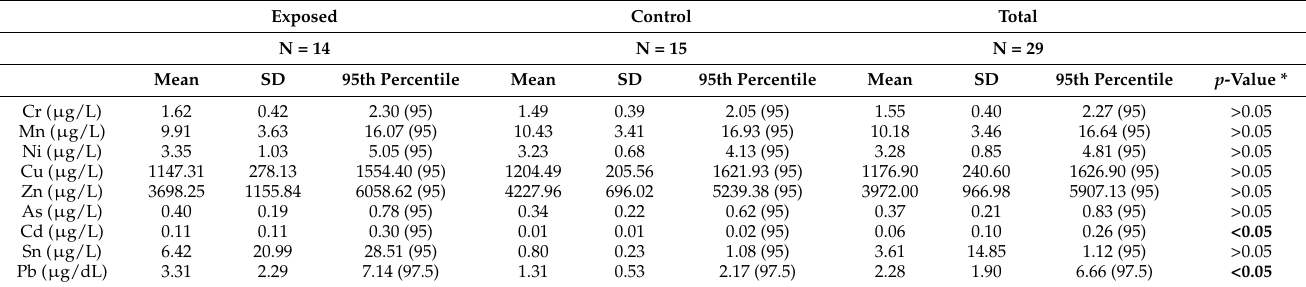
Table 5. Blood PTE levels determined in children. Limeira, Brazil, 2019.